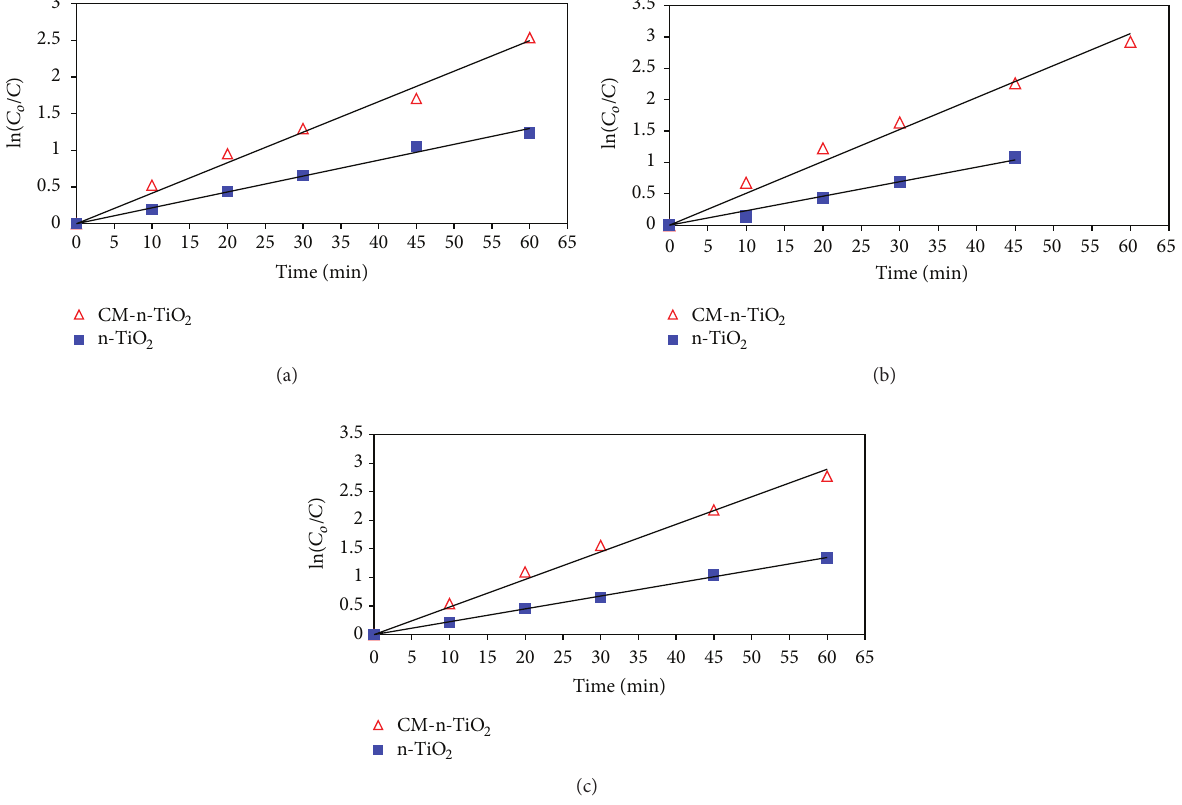
Figure 7: Kinetic analysis for the photocatalytic degradation of (a) Ar 1254 (0.5 ppm), (b) Ar 1260 (0.5 ppm), and (c) mixture of Ar 1254 (0.5 ppm) and Ar 1260 (0.5 ppm) in seawater using the pilot plant